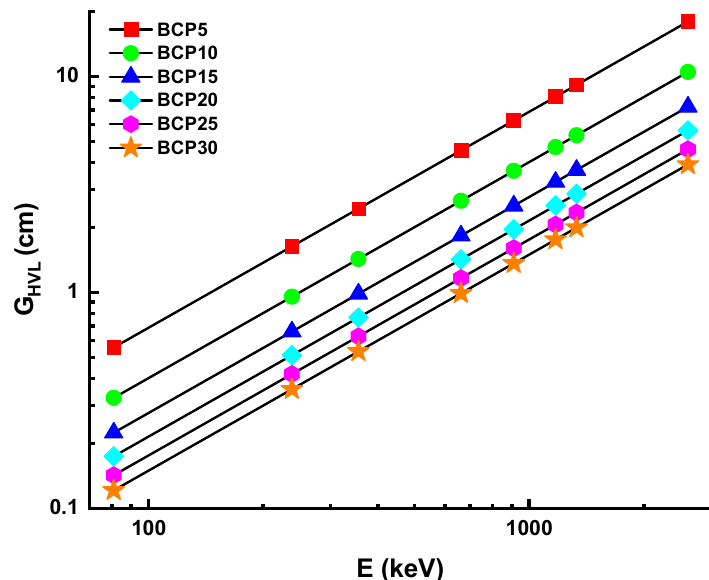
Figure 6. Variation of half-value layer (G HVL ) for prepared glasses.